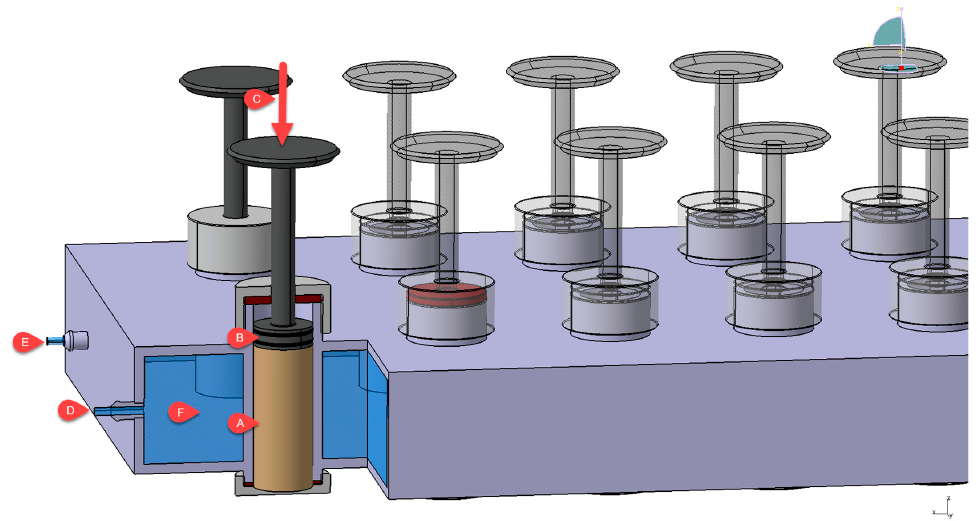
Figure 1. Scheme of the device used for delivering the temperature shocks under the load (A— sample chamber filled with fertilizer; B—piston; C—load; D—water inlet; E—water outlet; F—water circulation